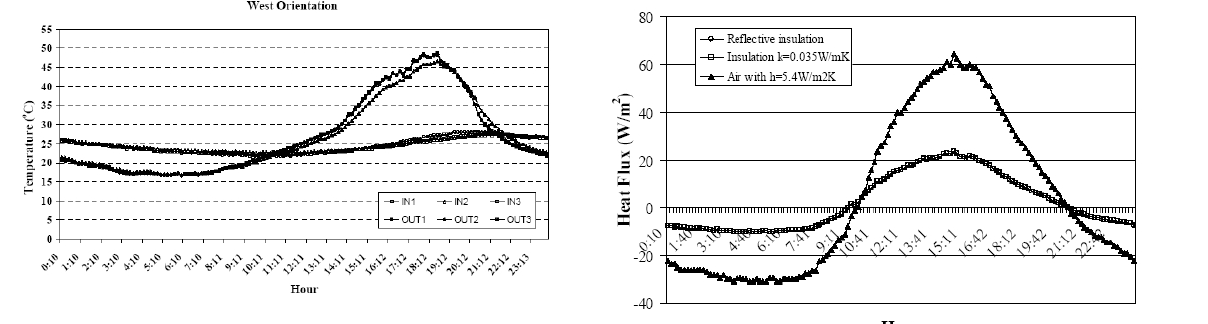
Figure 15. Heat flux calculation through south wall in August Summer period